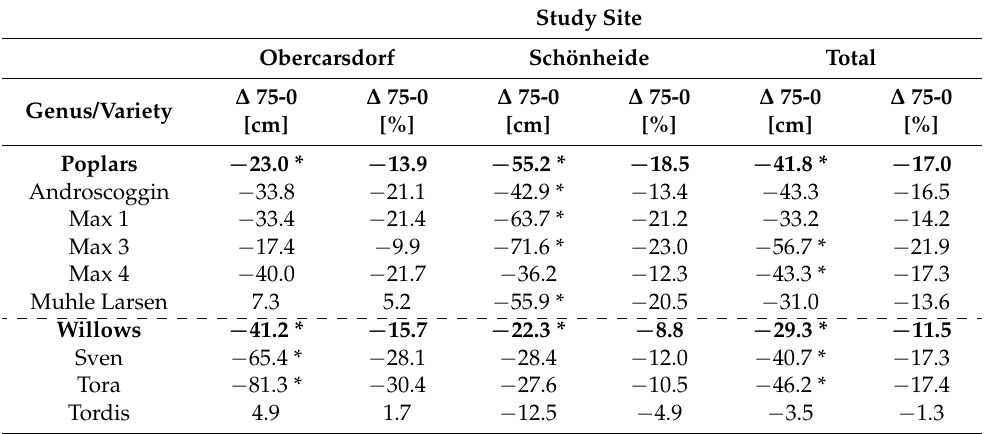
Table 11. Height differences between 75% defoliated and undefoliated plants ( ∆ 75-0) on the study sites in Obercarsdorf and Schönheide prior to the start of the growing season in April 2010 (* significant difference according to the t test or Welch test). Study Site Obercarsdorf Schönheide Total ∆ Genus/Variety